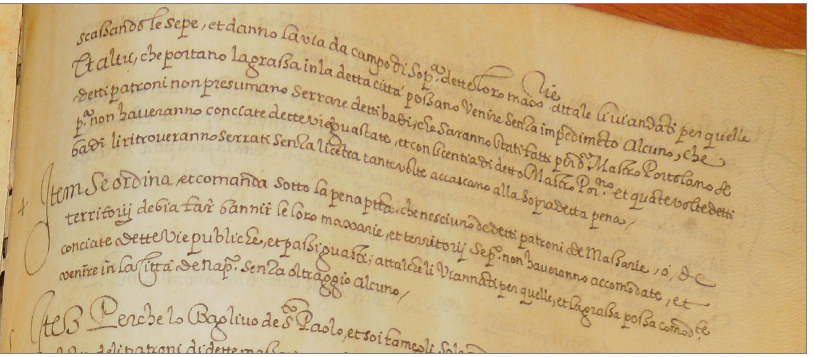
Figure 12. Line segmentation errors An example of a page whose lines of text baseline exhibit a non- uniform and very pronounced bending, leading all the methods, including the one here proposed, to